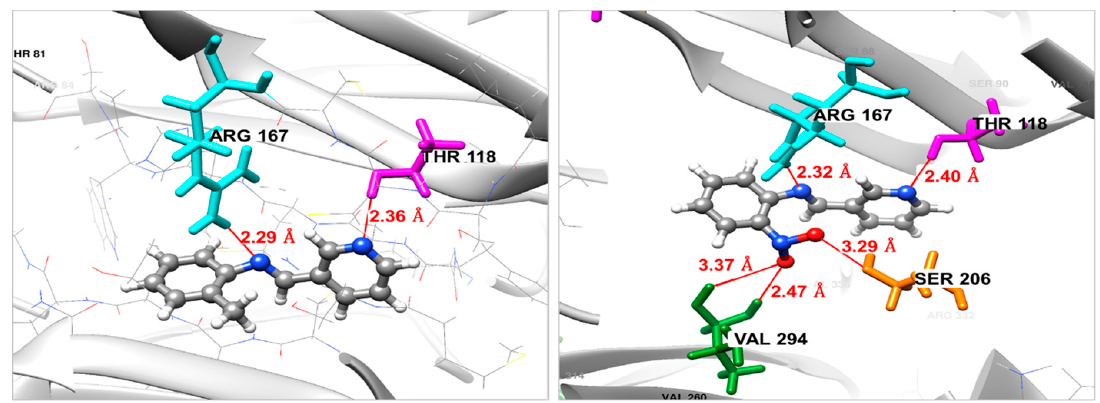
Figure 5. Binding mode of compound 2 ( left ) and compound 3 ( right ) in the active site of Fgb1 protein. For both 2 and 3 , gray color for carbon atoms, blue for nitrogen, red for oxygen and write color for hydrogen atoms.